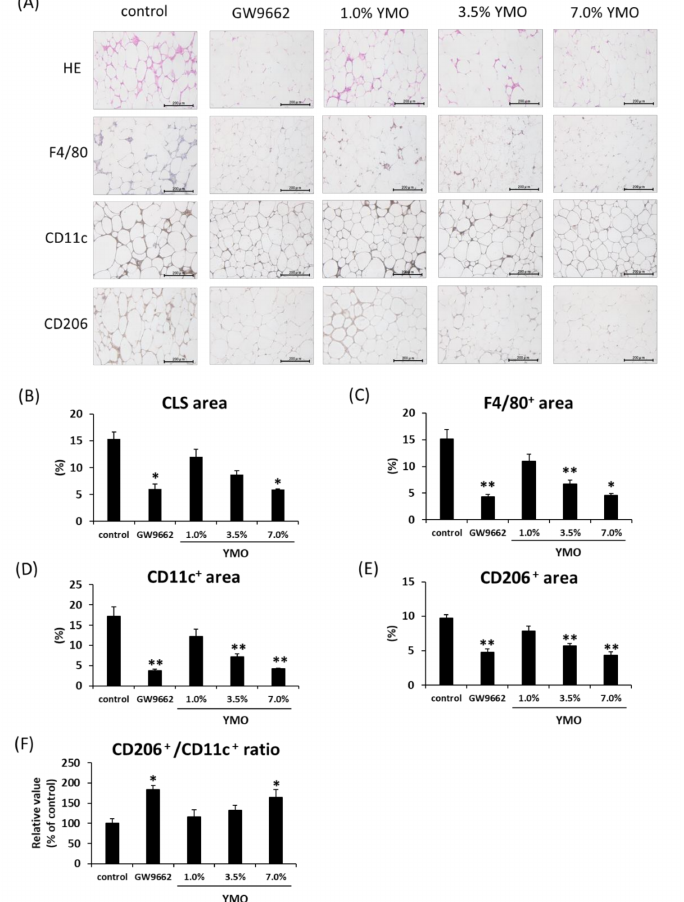
Figure 6. Effect of YMO on macrophage infiltration into perirenal adipose tissue in KK-A y mice. Perirenal adipose tissue was collected from KK-A y mice fed with 1.0, 3.5, or 7.0% YMO for 16 weeks. Paraffin sections of adipose tissue were stained with hematoxylin & eosin (HE), or immunos- tained with anti-F4/80, CD11c, or CD206 antibody. ( A ) Histological analytic image of HE staining and immunostainings, ( B ) Area of crown like structure (CLS), ( C ) F4/80 + area, ( D ) CD11c + area, ( E ) CD206 + area, ( F ) Ratio of CD206 + area/CD11c + area. Values are mean ± SE, n = 7. ** p < 0.01, * p < 0.05 versus